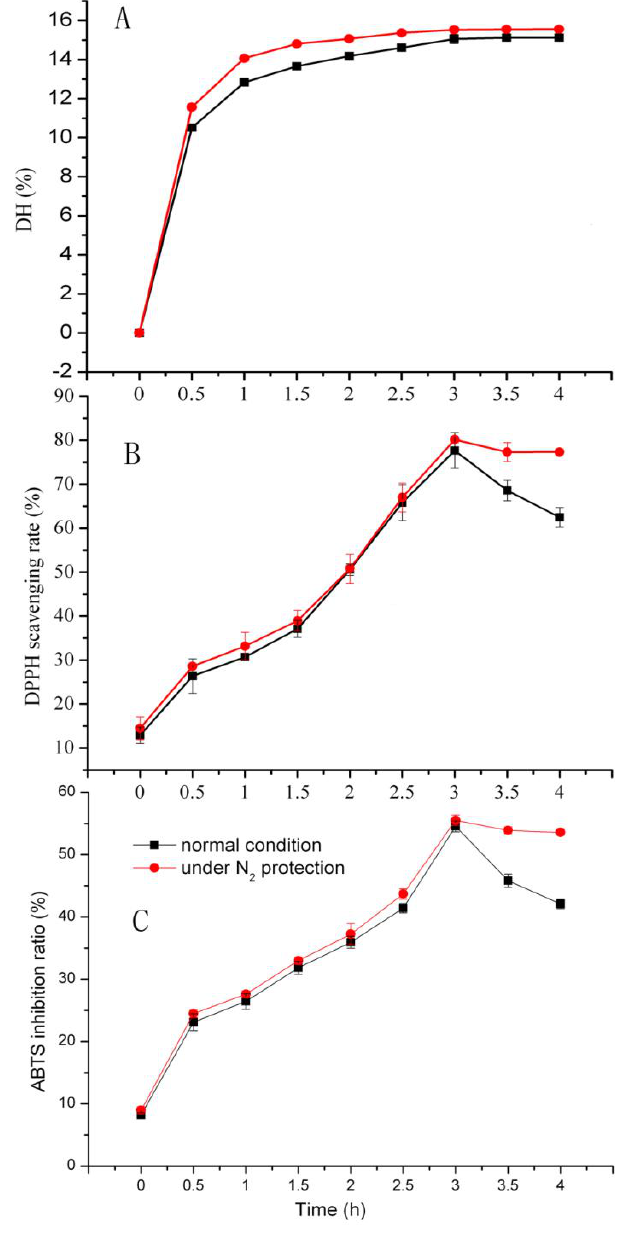
Figure 5. Antioxidant activity and degree of hydrolysis of swine bone